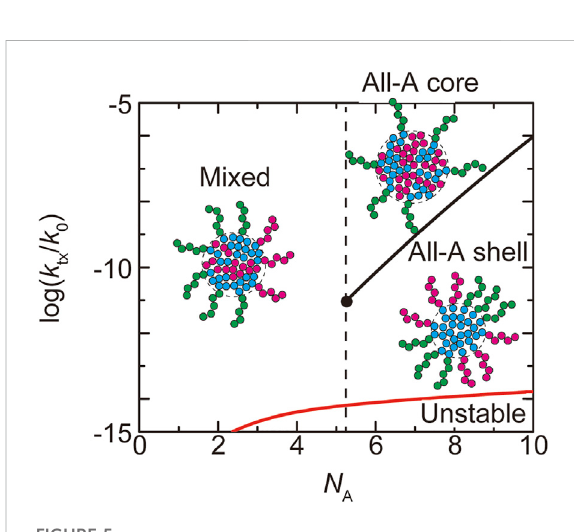
The phase diagram of paraspeckles is shown for the (natural) logarithm of production rate k tx of transcripts and the number N A of units in the A blocks. Paraspeckles are not stable in the region delineated by the red line. The values of parameters used for the calculations are N B = 40.0, N C = 15.0, χ B = 0.5, χ AB = 1.0. v A / b 3 (cid:1) v C / b 3 = 1.0, and C s = 1.5. The vertical broken line indicates the critical number N Ac of units in the A